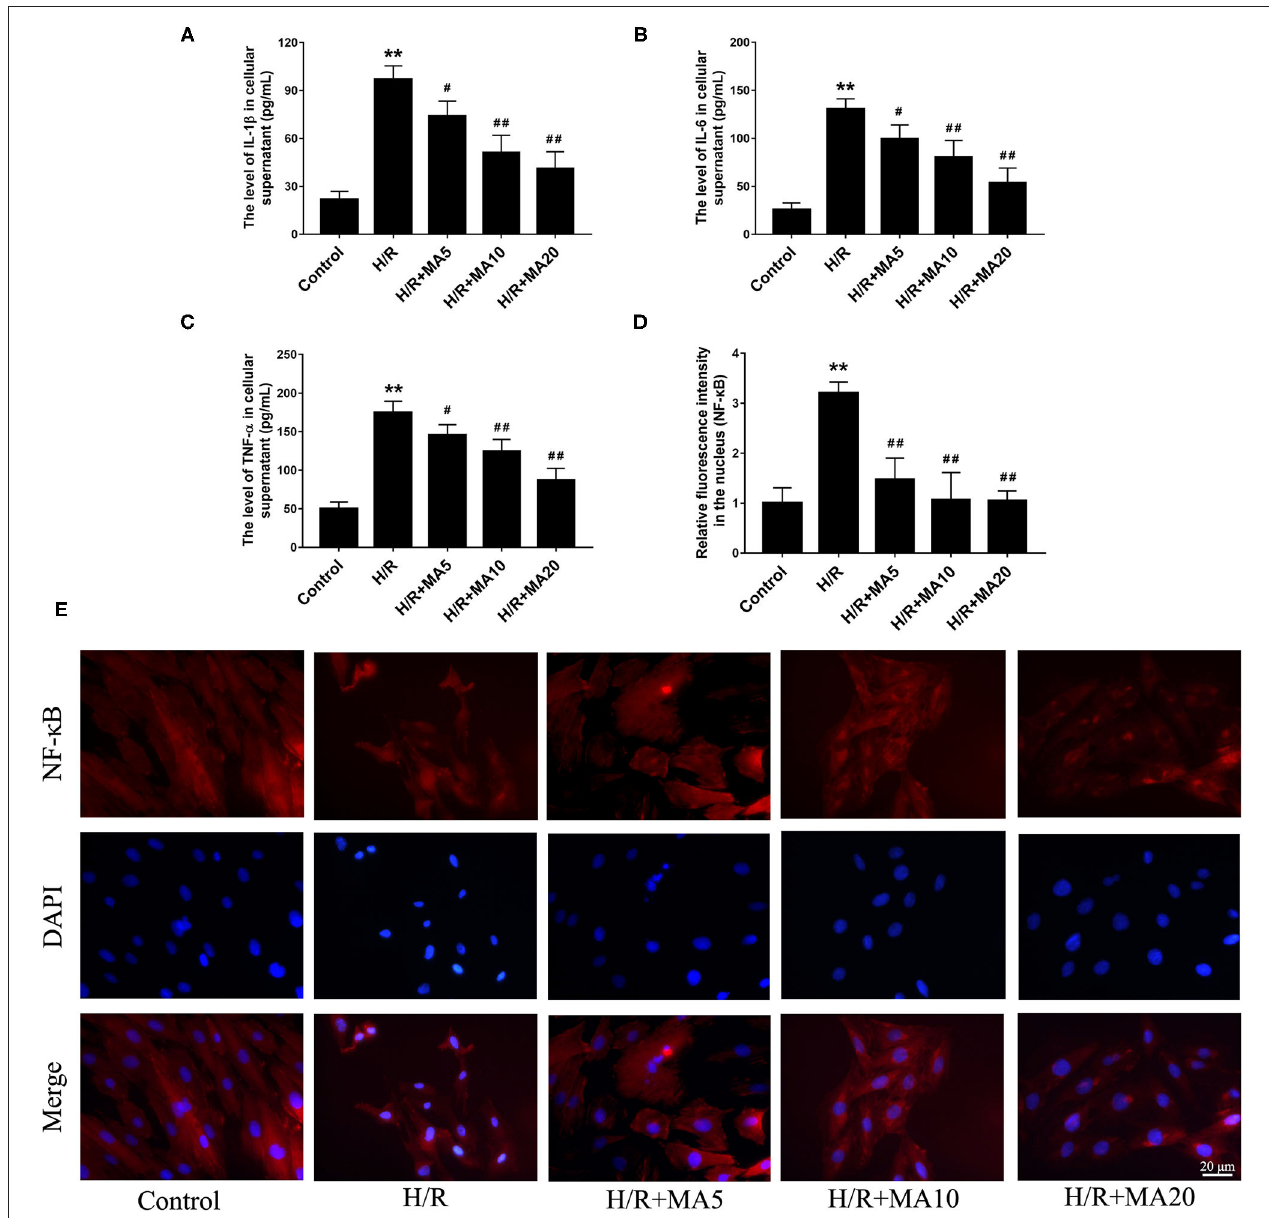
FIGURE 3 | The effects of MA on the inflammatory cytokines in cell supernatants and the NF-kB nuclear translocation after H/R treatment. (A–C) The levels of interleukin 1 β (IL-1 β ), interleukin 6 (IL-6), and tumor necrosis factor alpha (TNF- α ) in the cell supernatants were assessed by the specific enzyme-linked immunosorbent assay (ELISA) analyses. (D,E) The nuclear translocation of nuclear factor- κ B (NF- κ B) p65 in a H9c2 cell was investigated by immunofluorescence staining. NF- κ B p65 (red), 4 ′ ,6-diamidino-2-phenylindole (DAPI)-labeled nuclei of cardiomyocytes (blue) and merged images show NF- κ B translocation into the nucleus (purple). The quantification analysis of the mean fluorescent intensity in the nucleus is shown in bar graphs. All the values are representative of at least three independent experiments and expressed as the mean ± SD. ** P < 0.01 vs. control group; # P < 0.05 and ## P < 0.01 vs. H/R group.